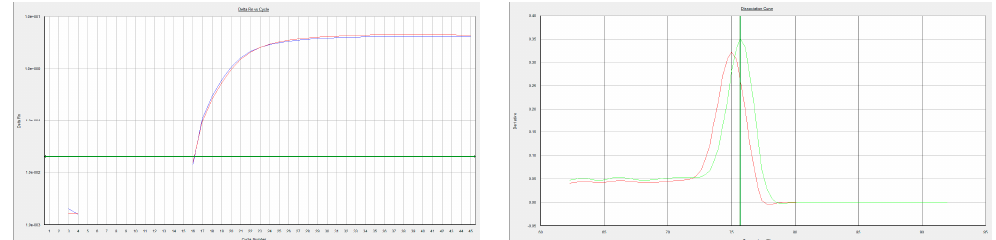
Figure 4. Amplification and melting curves of WA. Amplification curves of WA (red, Ct = 16.06) and generic (blue, Ct = 16.06) assay. Melting curve of WA (Tm = 75.0 °C) and generic (Tm = 75.7 °C) assay.